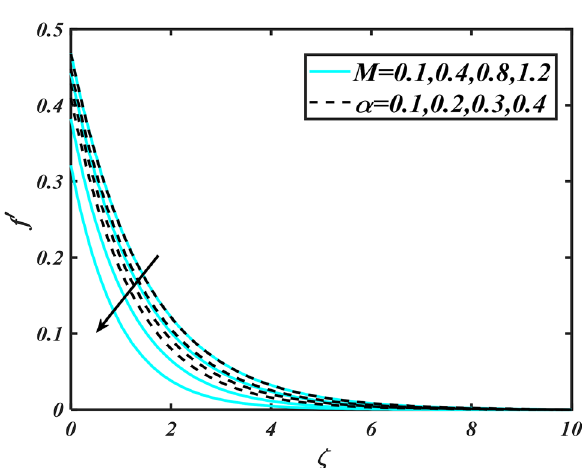
Figure 2. Aspects of M & α versus f ′ .